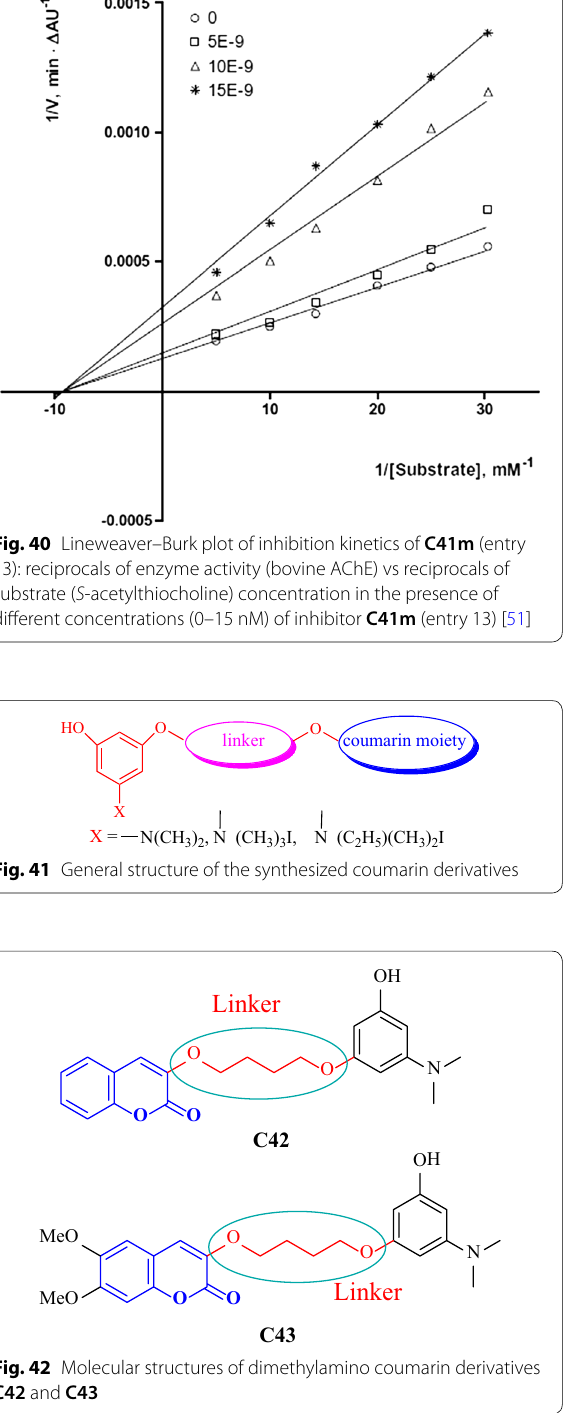
Fig. 43 a Plot showing the absolute incremental variation (from the initial conformations obtained from molecular docking) of the half-sum of distances calculated from the centres of mass of residues W286 and Y341, and the centroid of the coumarin ring of inhibitor C43 over 5 ns MD simulations. b A representative sandwich-like binding conformation of C43 taken after 5 ns MD simulations